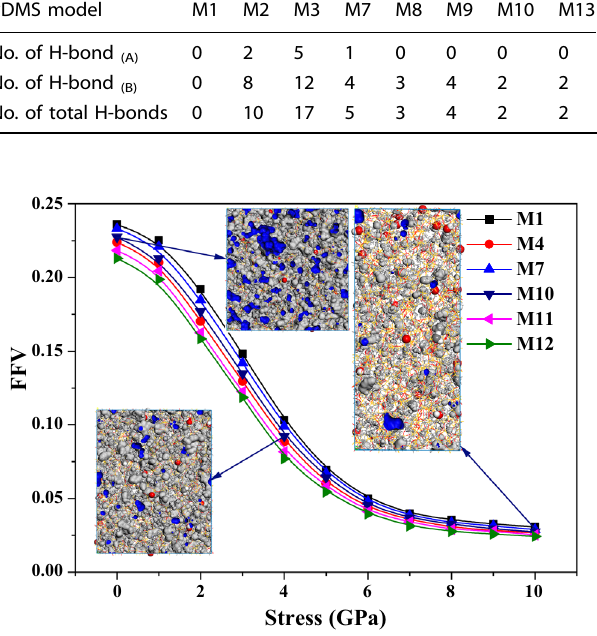
Fig. 5 FFVs of the unaged and aged PDMS models under different stress levels. The blue and gray regions in the insets represent the free volume and the occupied volume,